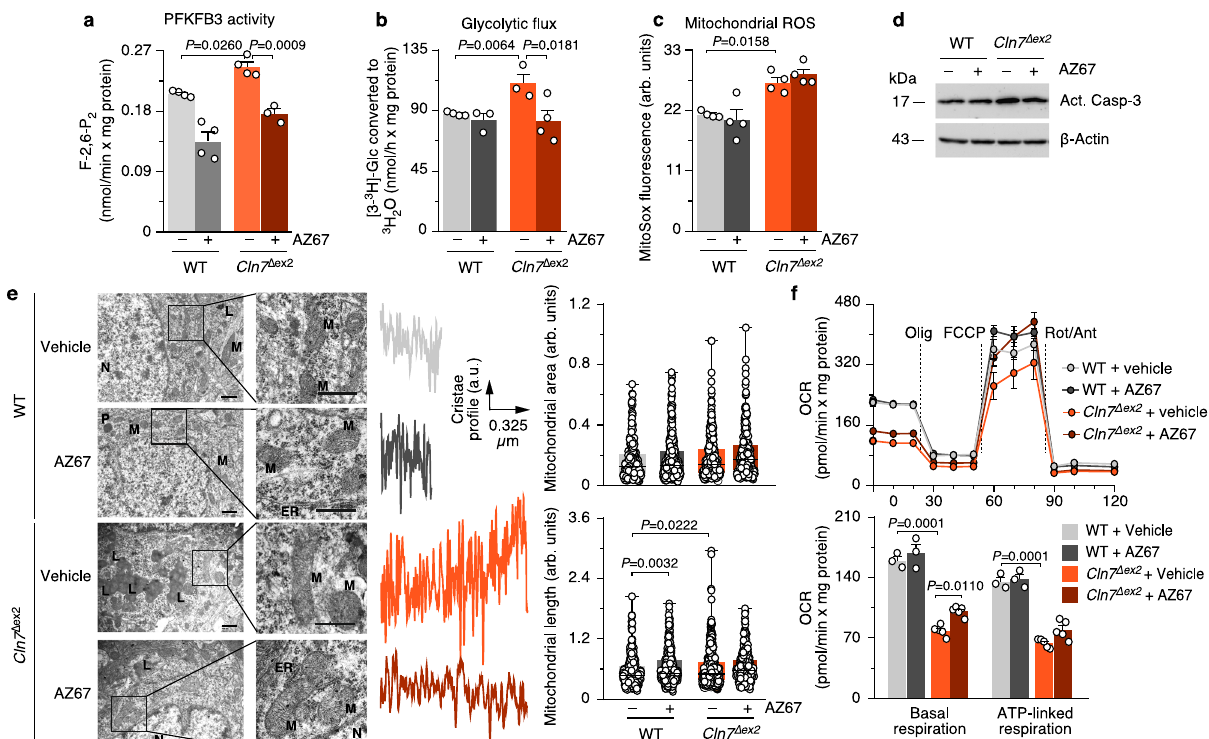
Fig. 4 Pharmacological targeting PFKFB3 restores mitochondrial alterations of Cln7 Δ ex2 disease in vivo. a – d Analysis of PFKFB3 activity ( a ), glycolytic fl ux ( b ), mitochondrial ROS ( c ), and a representative active caspase-3 by western blot ( d ), in primary neurons incubated with the PFKFB3 inhibitor